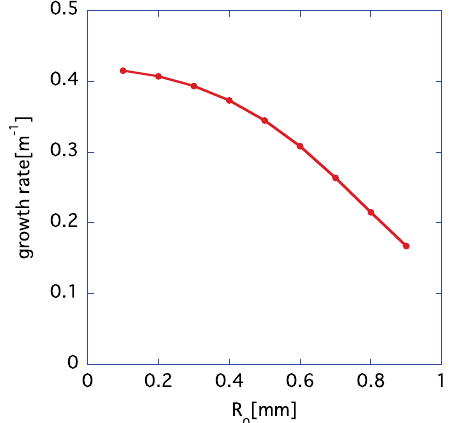
FIG. 3. The dependence of the growth rate on the beam size R 0 10 and Δ E=E ≃ 0 . 4% with γ r ¼